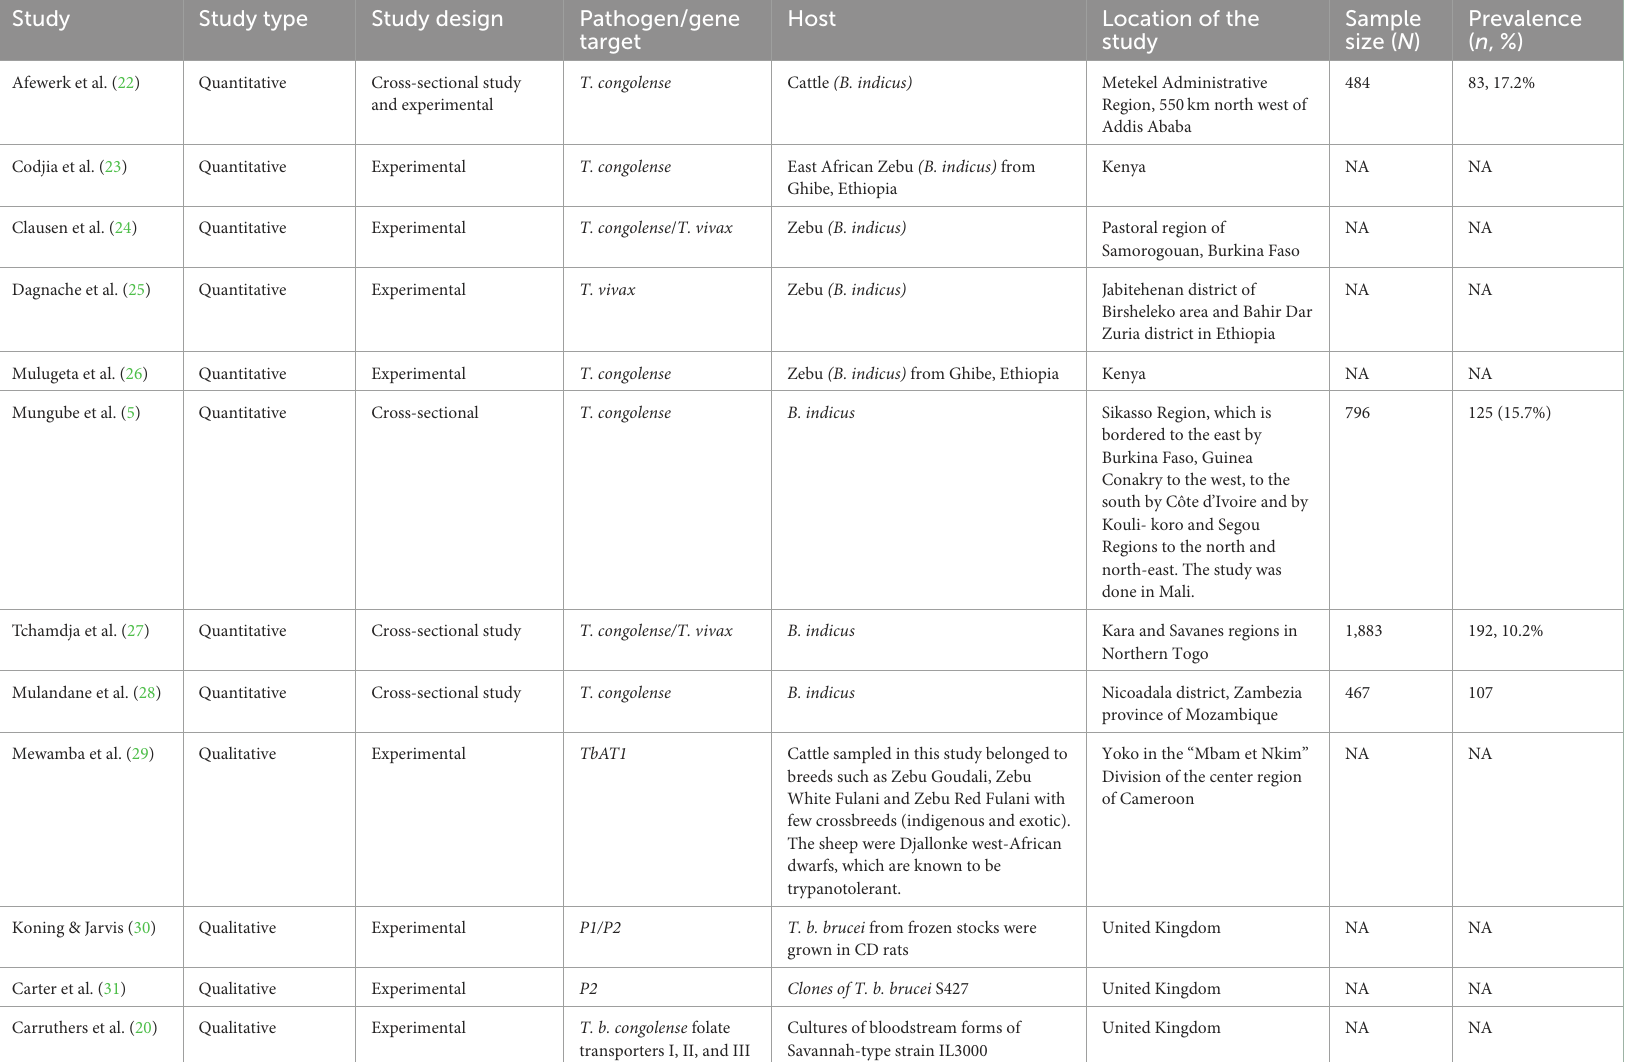
TABLE 2 Description of study publication on trypanosome pathogen, primary host, and location of study and